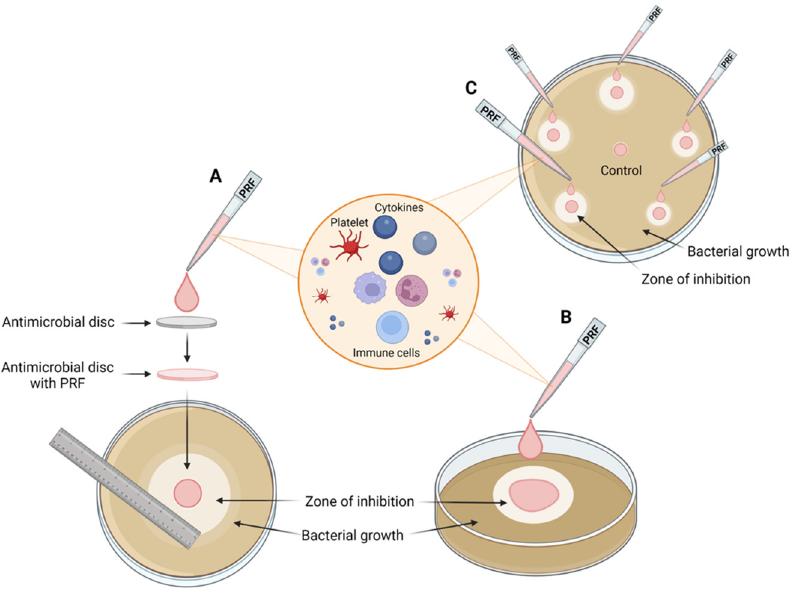
Figure 3. Diffusion methods for in vitro evaluation of antimicrobial activity: ( A ) Disk diffusion method; ( B ) agar diffusion method; ( C ) agar-well diffusion method. All figures created with Bioren- der.com.